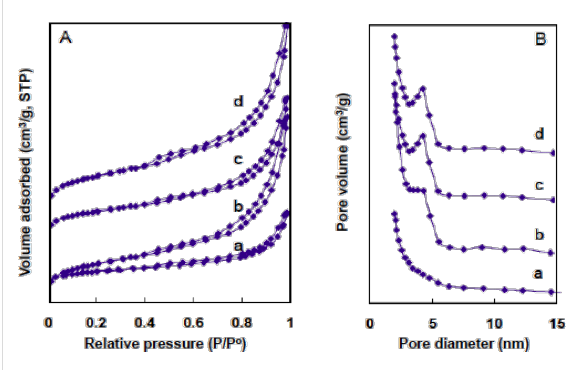
Figure 6: N 2 adsorption/desorption isotherms (A) and BJH pore-size distribution curves obtained from the adsorption branch (B) of silica nanostructures synthesized by using silica source (MS51) concentra- tions of 23.1 wt % (a), 9.1 wt % (b), 4.6 wt % (c) and 1.1 wt % (d). LPEI aggregates was prepared by first dropping 1.0 mL of aqueous NaOH solution (5.0 M) into a mixture of 0.5 g of LPEI·HCl and 5 mL of water ([OH]/[EI] = 0.8), then washing the crystalline LPEI aggregates to pH 7.0 with centrifugation–redispersion cycles. The silica deposition condi- tions are the same as described in Figure